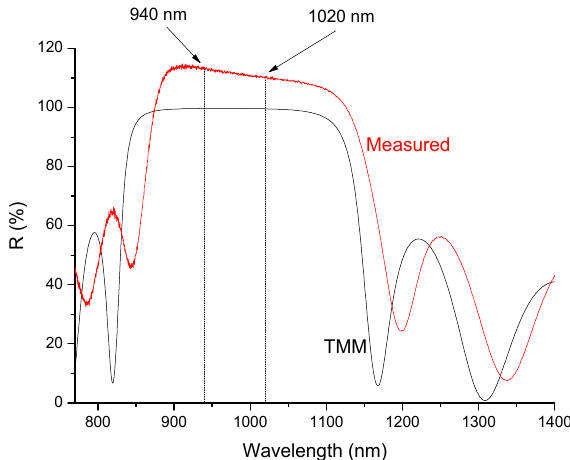
Figure 8. Measured reflectance spectrum of a Bragg Mirror (BM) with 7 pairs of AS/T layers deposited on a Si wafer, compared with Transfer Matrix Method (TMM) simulation.